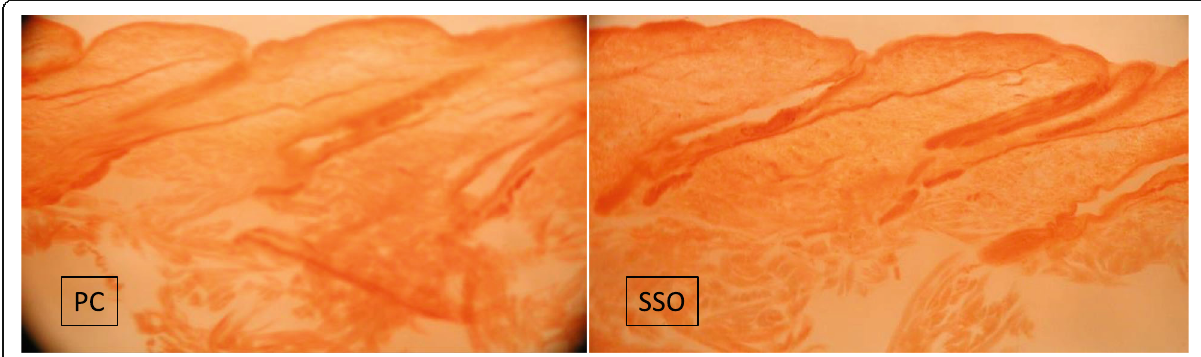
Fig. 6 Sudan (IV) stain test results for the leather test pieces, PC, and SSO